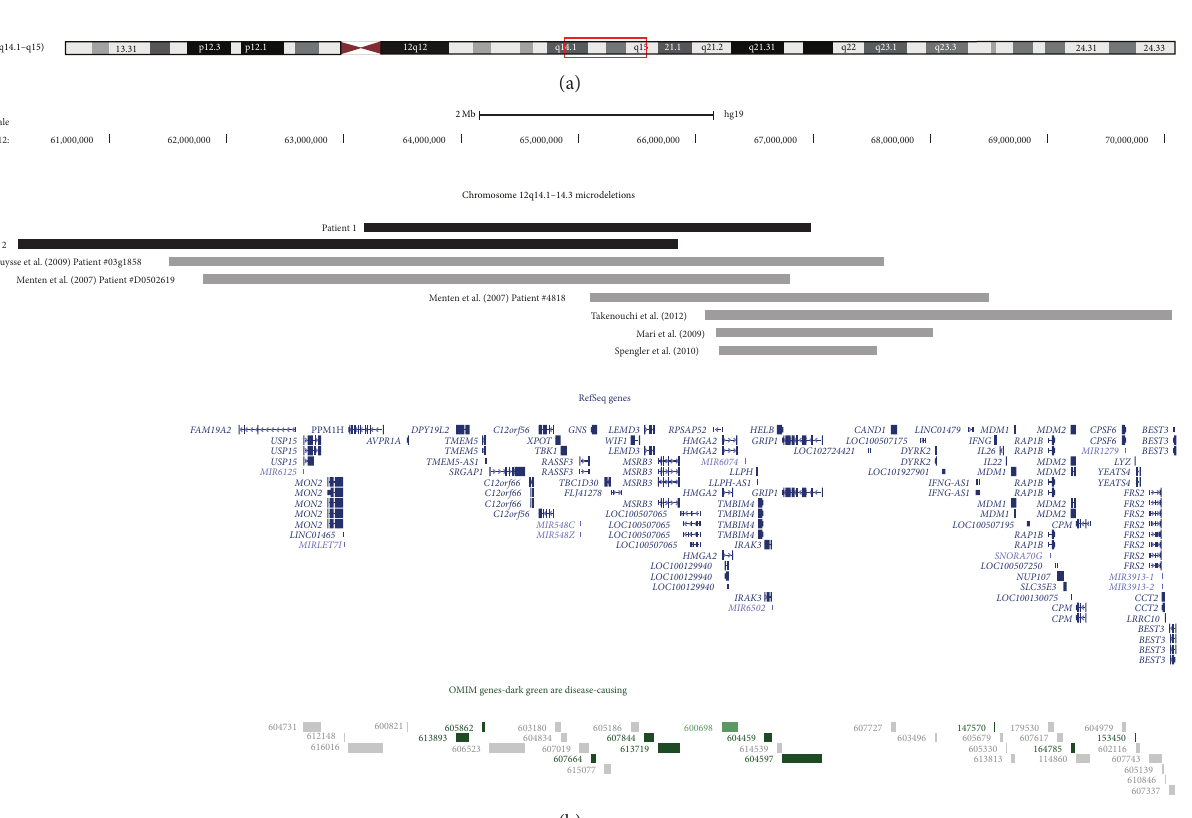
Figure 2: Schematic of chromosome 12q14 containing microdeletions. (a) shows an ideogram of chromosome 12. (b) shows the location and extent of the deletions detected in the patients described here and other cases reported in the literature, as well as RefSeq and OMIM genes that lie within 12q14. These graphics were taken from the UCSC genome browser (http://genome.ucsc.edu/).